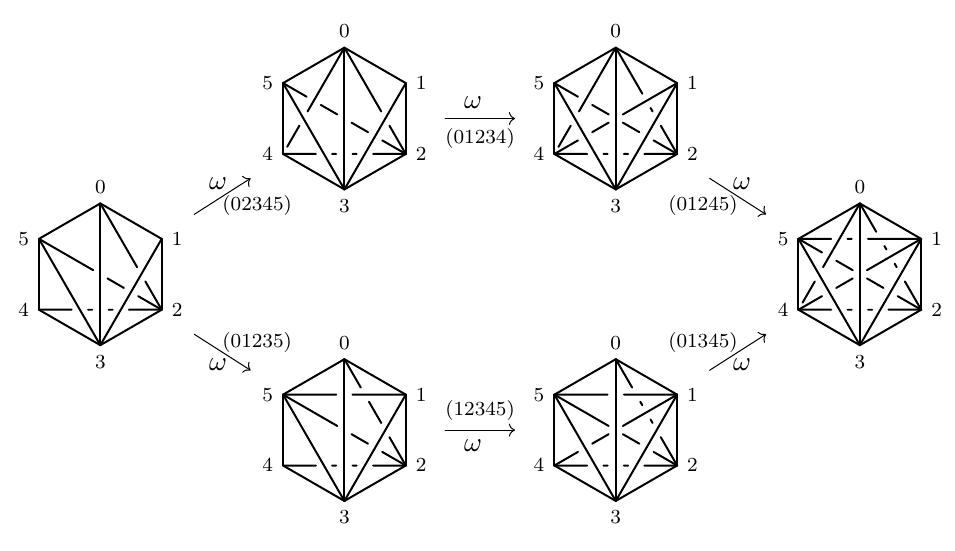
Figure 1 . Consistency condition of the 2{3 Pachner move whose amplitude is given by the 2-form 4-cocycle ! 2 Z 4 ( G ; U(1)). Starting from the union of three 3-simplices, there exist two di(cid:11)erent [2] successions of 2{3 Pachner moves which lead to the same union of six 3-simplices. On each arrow we indicate the 4-simplex bounded by the (cid:12)ve 3-simplices involved in the Pachner move, on which the 2-form cocycle is